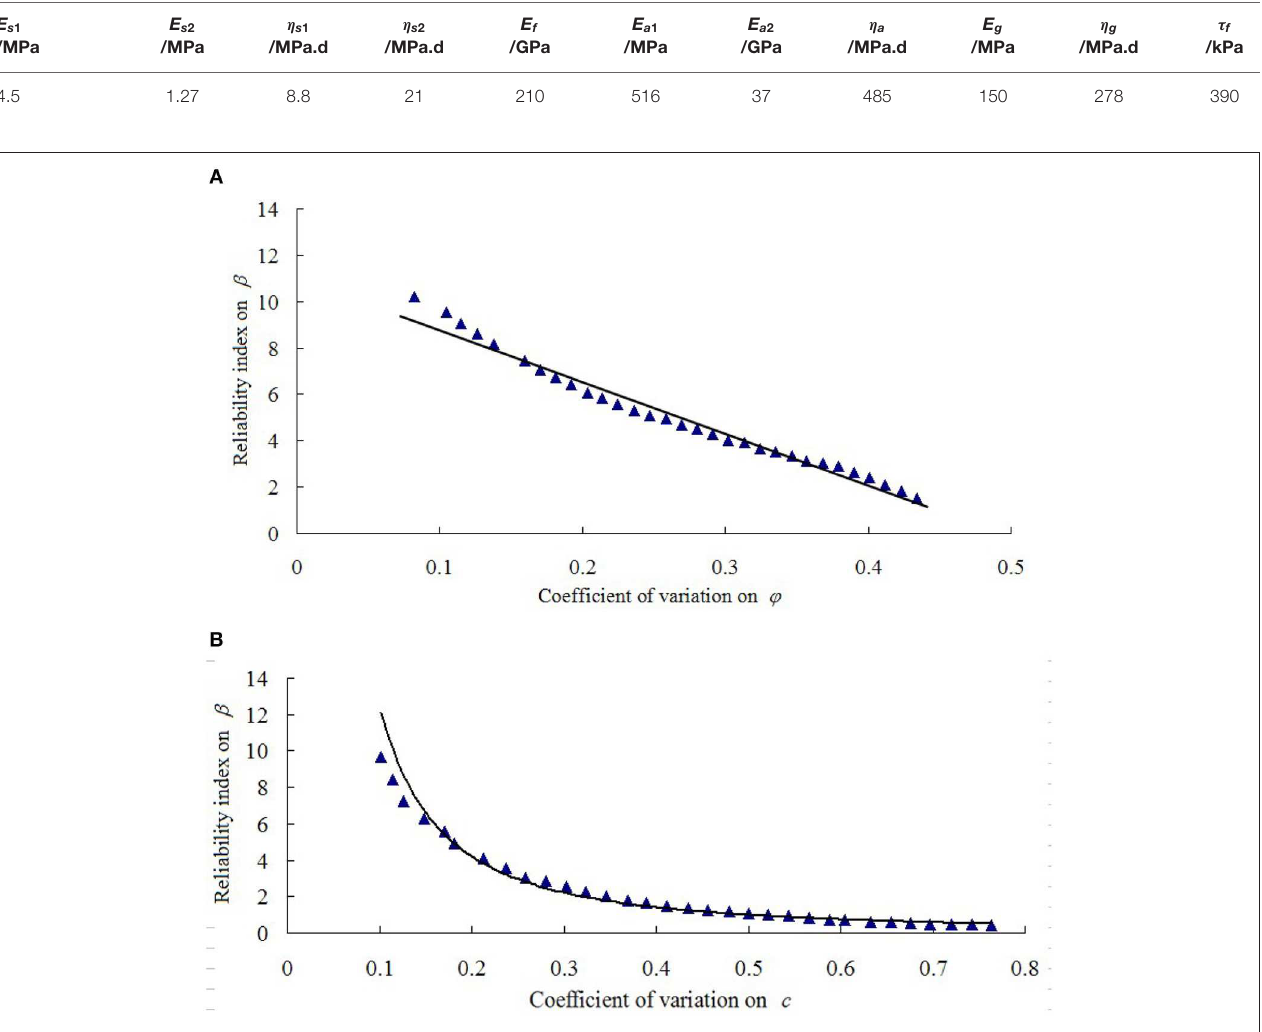
FIGURE 4 | Curve of reliability index and shear strength: (A) Curve of the reliability index and the internal friction angle, (B) Curve of the reliability index and the cohesion.